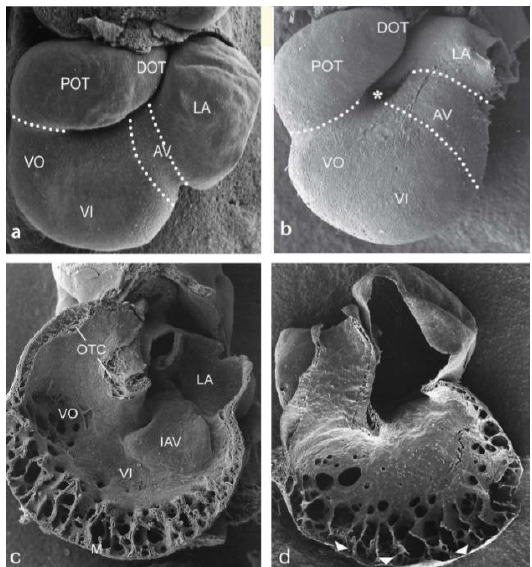
Table 1. Cardiovascular abnormalities after ligation. The number and percentage of malformations are indicated for each stage. Different malformations were sometimes observed in the same embryo, therefore, the sum of a column can exceed 100%.